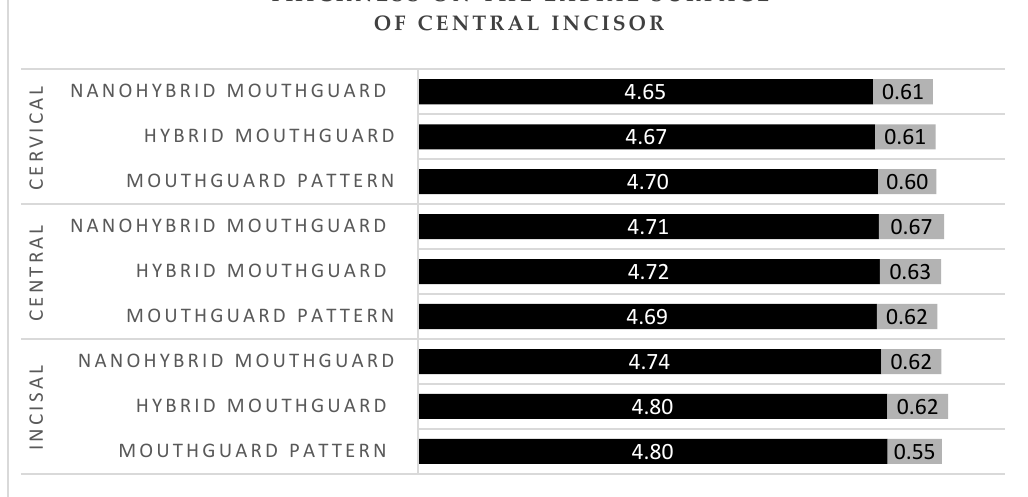
Figure 4. Thickness at the labial surface of the central incisor. Black — mean value; grey — standard deviation (SD).